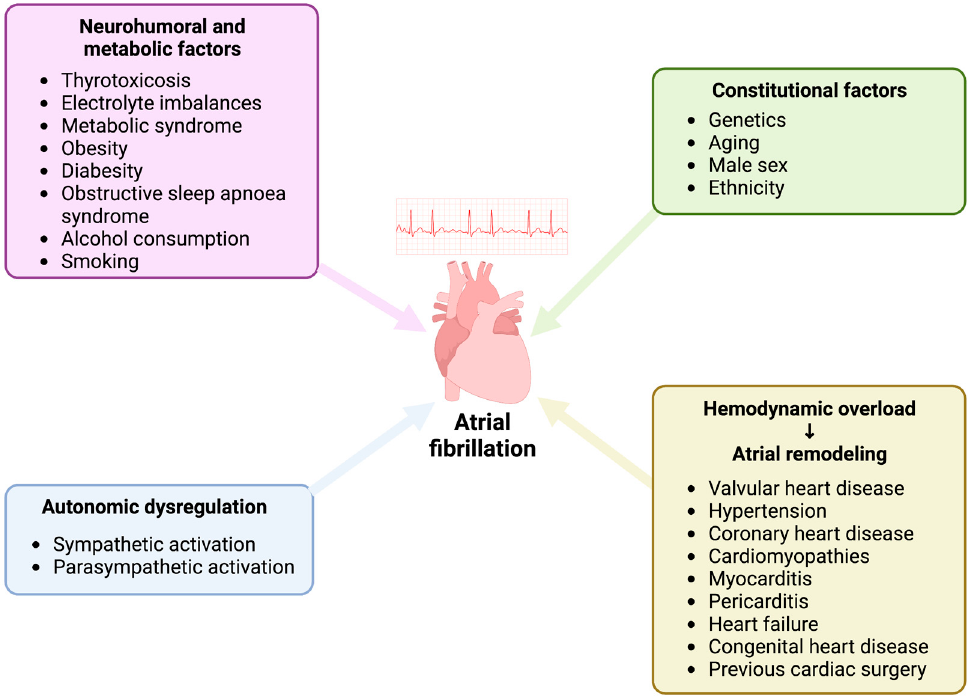
Figure 5. Potential pathophysiological mechanisms of AF. Created with www.biorender.com.